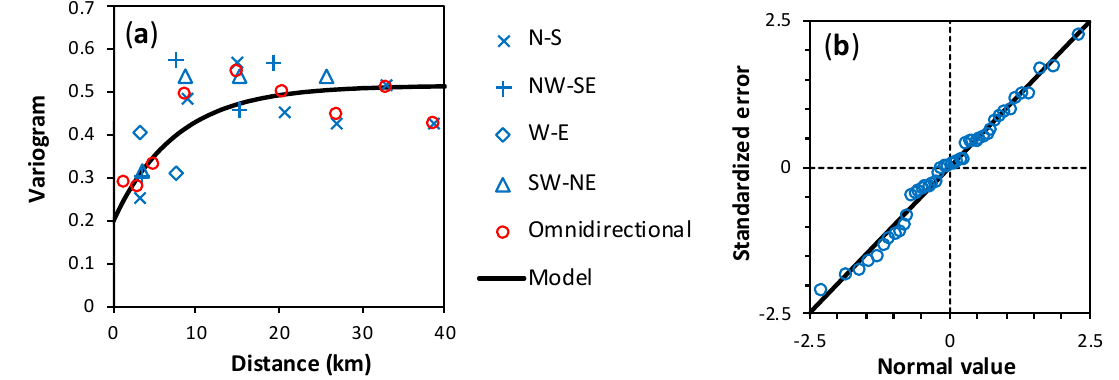
Figure 6. Empirical variogram in different directions and fitted omnidirectional exponential model variogram with parameters given in Table 2 ( a ); verification of the variogram model by cross-validation, showing the quantiles of the standardized errors and the corresponding quantiles from a standard normal distribution ( b ).